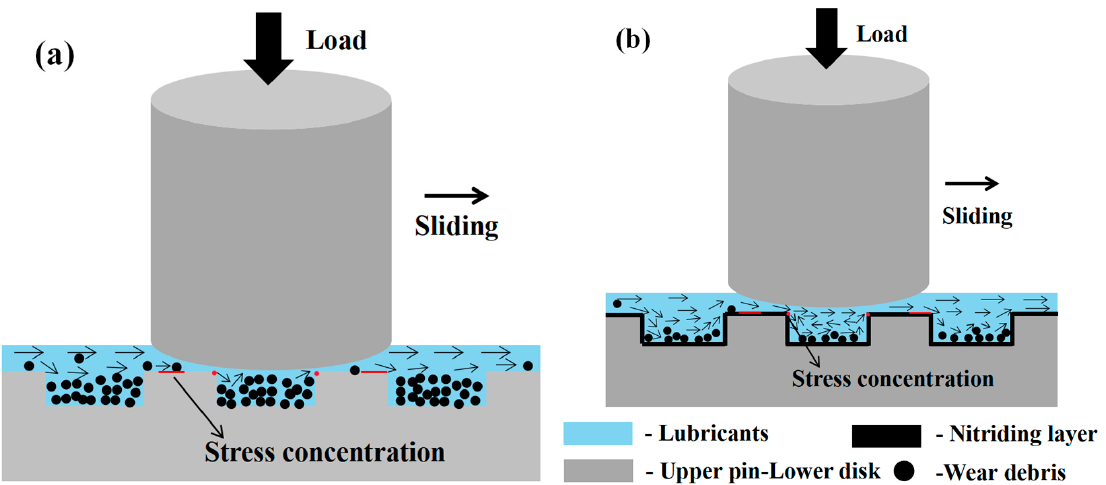
Figure 19. Wear mechanism diagram. ( a ) Texture only. ( b ) Texture composite nitriding.